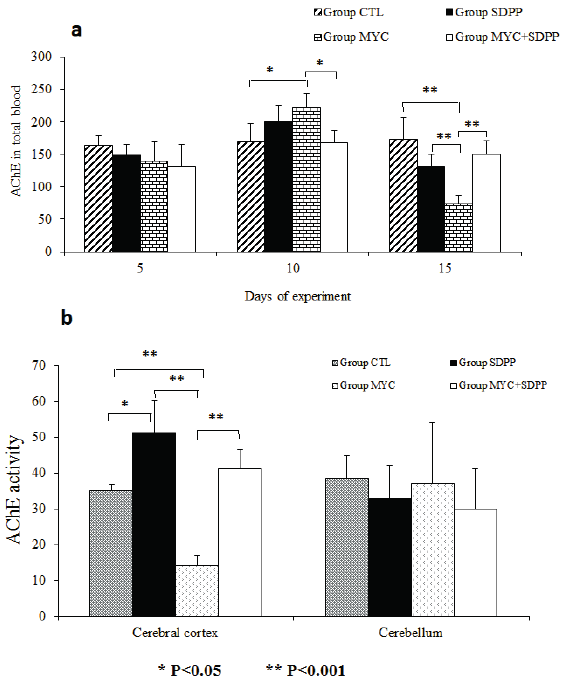
Figure 1 - AChe activity in whole blood (mU AcSCh/umolHb), cerebral cortex and cerebellum (µmol AcSCh/h/mg protein) of piglets treated with mycotoxins and spray-dried porcine plasma (SDPP) (experiment I). Ctl group: control diet; SDPP group: control diet and 6% of SDPP; MYC group: 210 µg/kg aflatoxins and 6.690 µg/kg fumonisins; MYC+SDPP group: 253 µg/kg aflatoxins, 6.930 µg/kg of fumonisins and 6% SDPP. Bars represent means ± standard deviation. Comparison among the four groups, in each separate period of the experiment or brain structure (ANOVA followed by the Duncan test). One asterisk (*) or two asterisk (**) illustrates the difference between groups in the probability of <0.05 and <0.001,